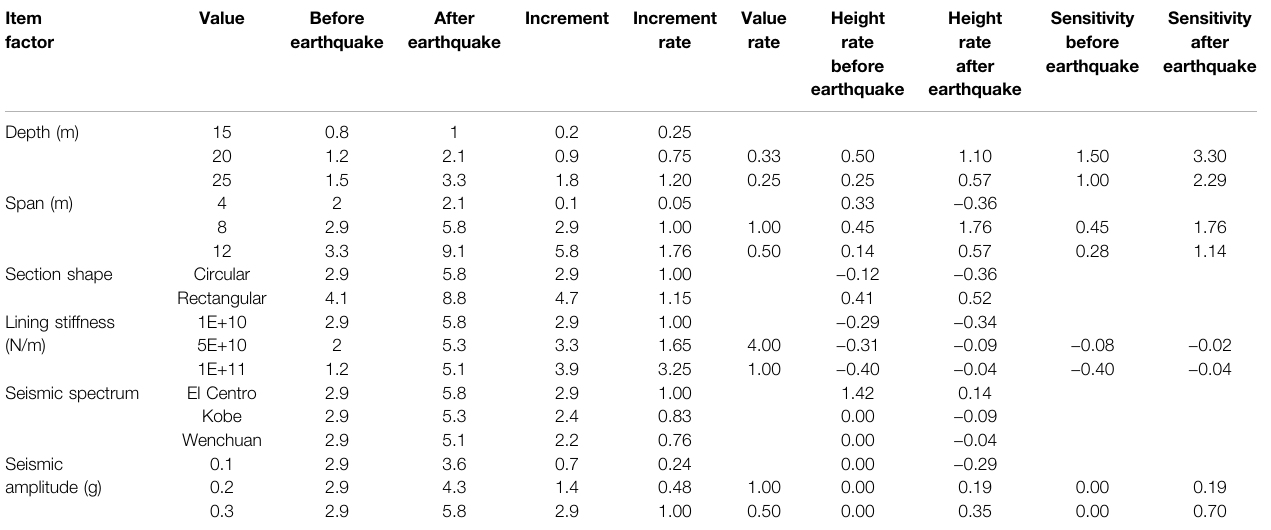
TABLE 3 | Factors in fl uencing the height of pressure arch above